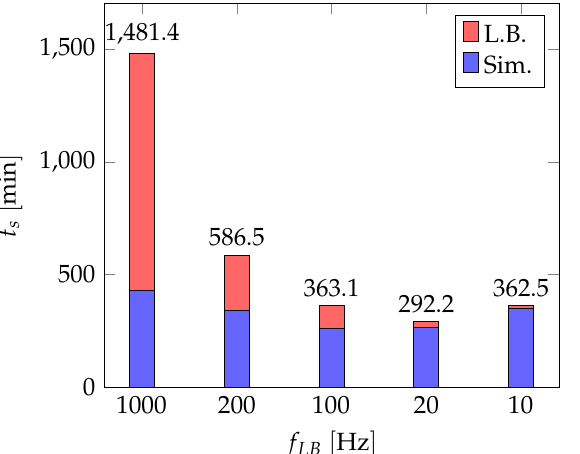
Figure 5. Simulation times of the packing of 1M particles benchmark on 64 processes with frequent load-balancing at f LB = 10, 20, 100, 200 and 1000Hz. Load-balancing time is illustrated using the red color.